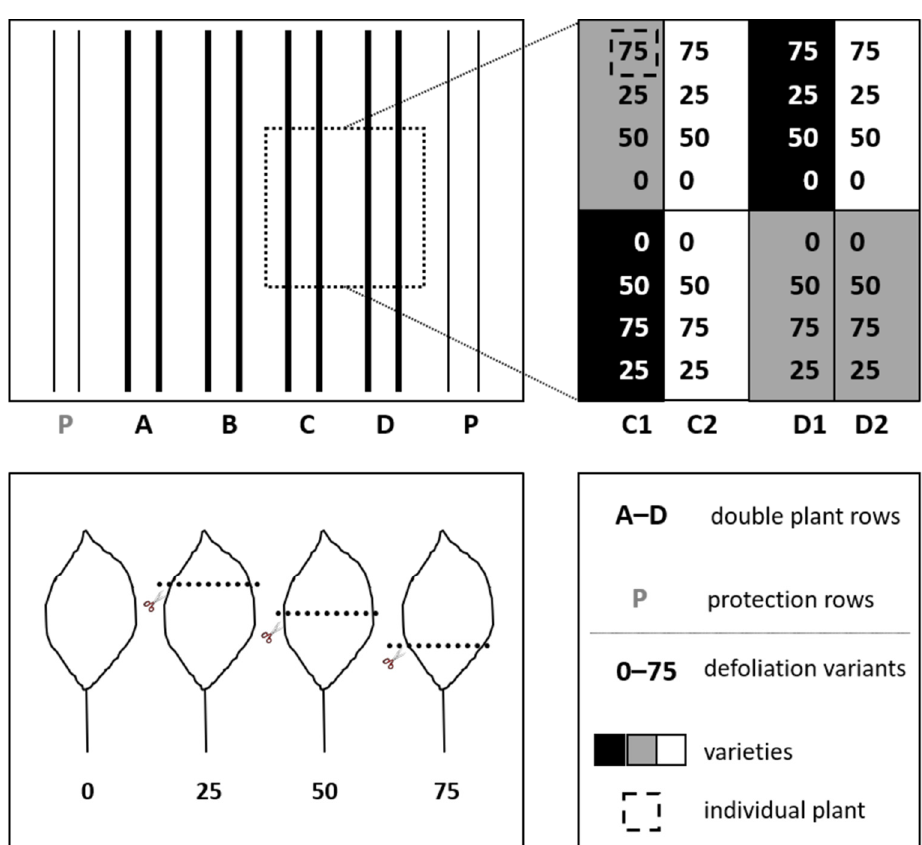
Figure 1. Planting design of the sample short rotation coppices ( above ) and design of leaf clipping of the different defoliation treatments ( below